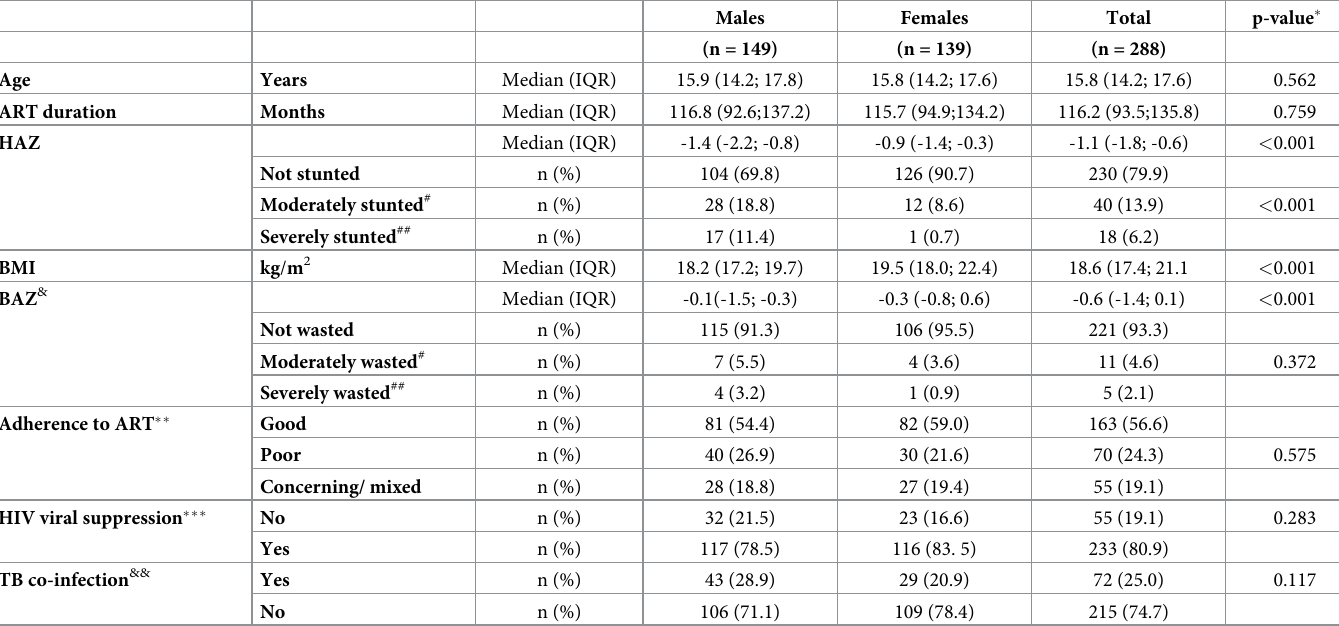
Table 2. Characteristics at study exit of adolescents living with perinatally-acquired HIV infection.